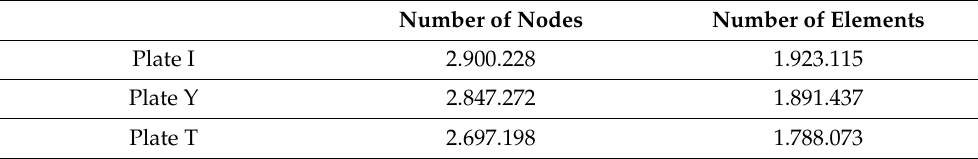
Figure 5. Mesh generated from the three-dimensional model. Table 2. Material properties used in the present numerical analysis.